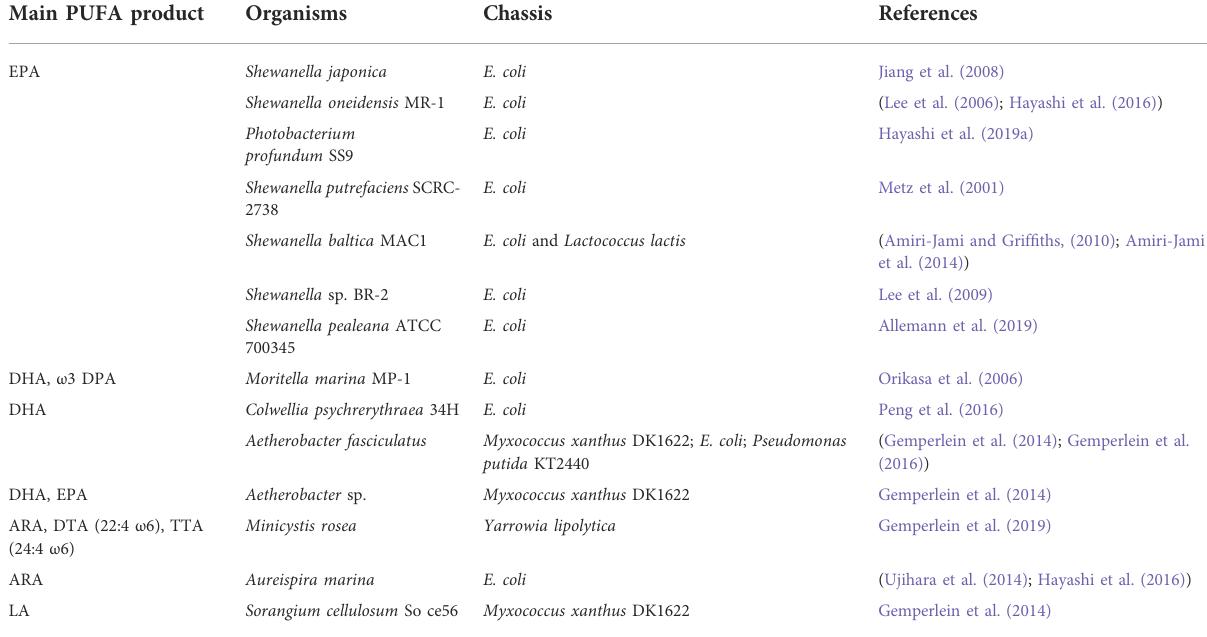
TABLE 3 Prokaryotic PUFA synthases identi fi ed by heterologous expression. Main PUFA